Question: According to this chart, does the measure grow or shrink?
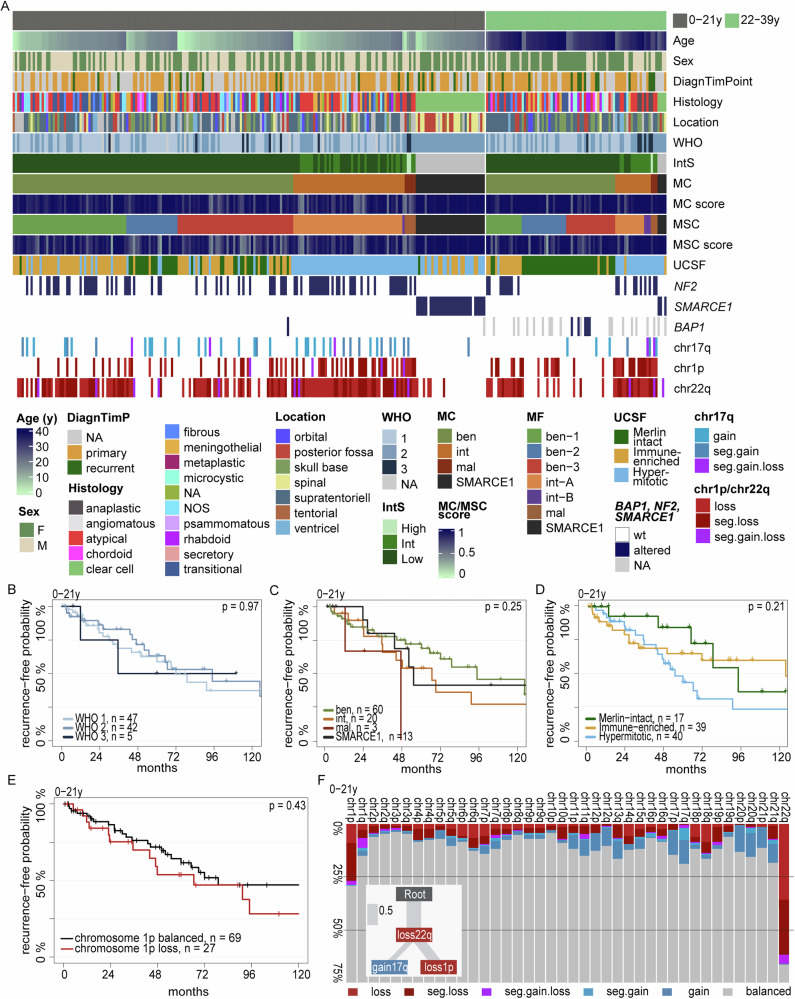
Answer: increasing